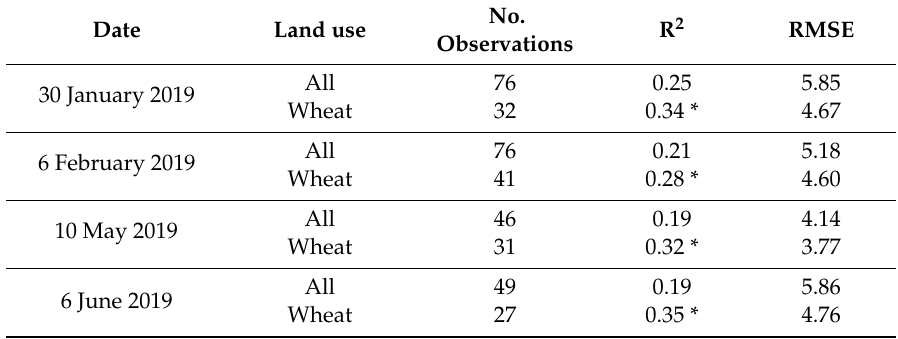
Table 6. Multiple linear regression statistics of the model based on two scenarios, model of all land uses and model of wheat land